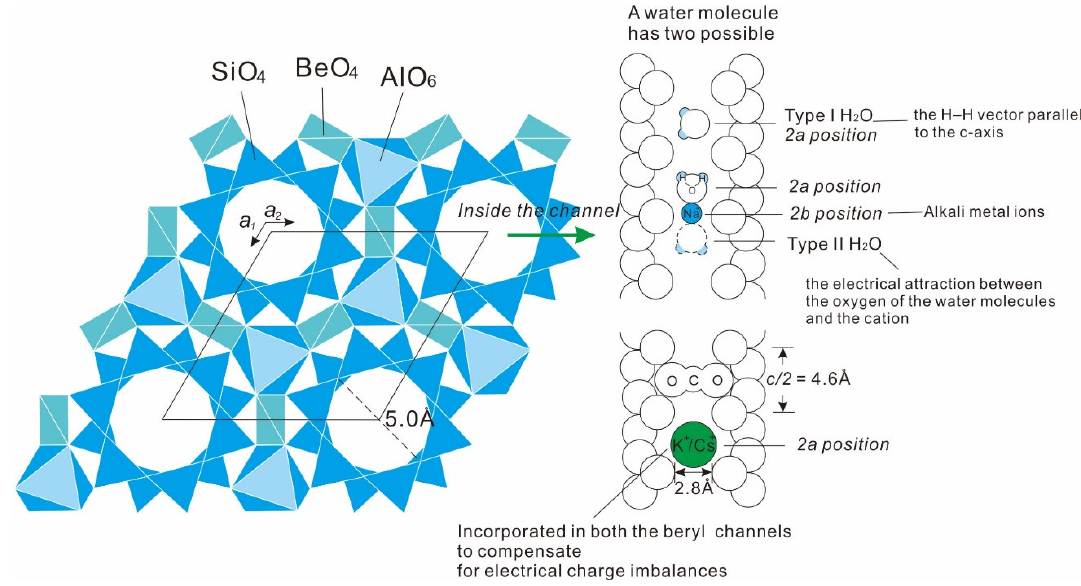
Figure 9. Stacked-ring structure of beryl [45]. According to the experimental results of Wood and Nassau [37], there are two types of H 2 O molecule occupancy in the open cavities of a beryl. When H 2 O is not paired with an alkali metal ion, the H–H vector is parallel to the c -axis (type I water). When an extra-framework cation is present near H 2 O molecules, the H 2 O molecules above and below the cation orient with their H–H vectors vertical to the c -axis because of the electrical attraction between the oxygen of the water molecules and the cation (type II water) [45].